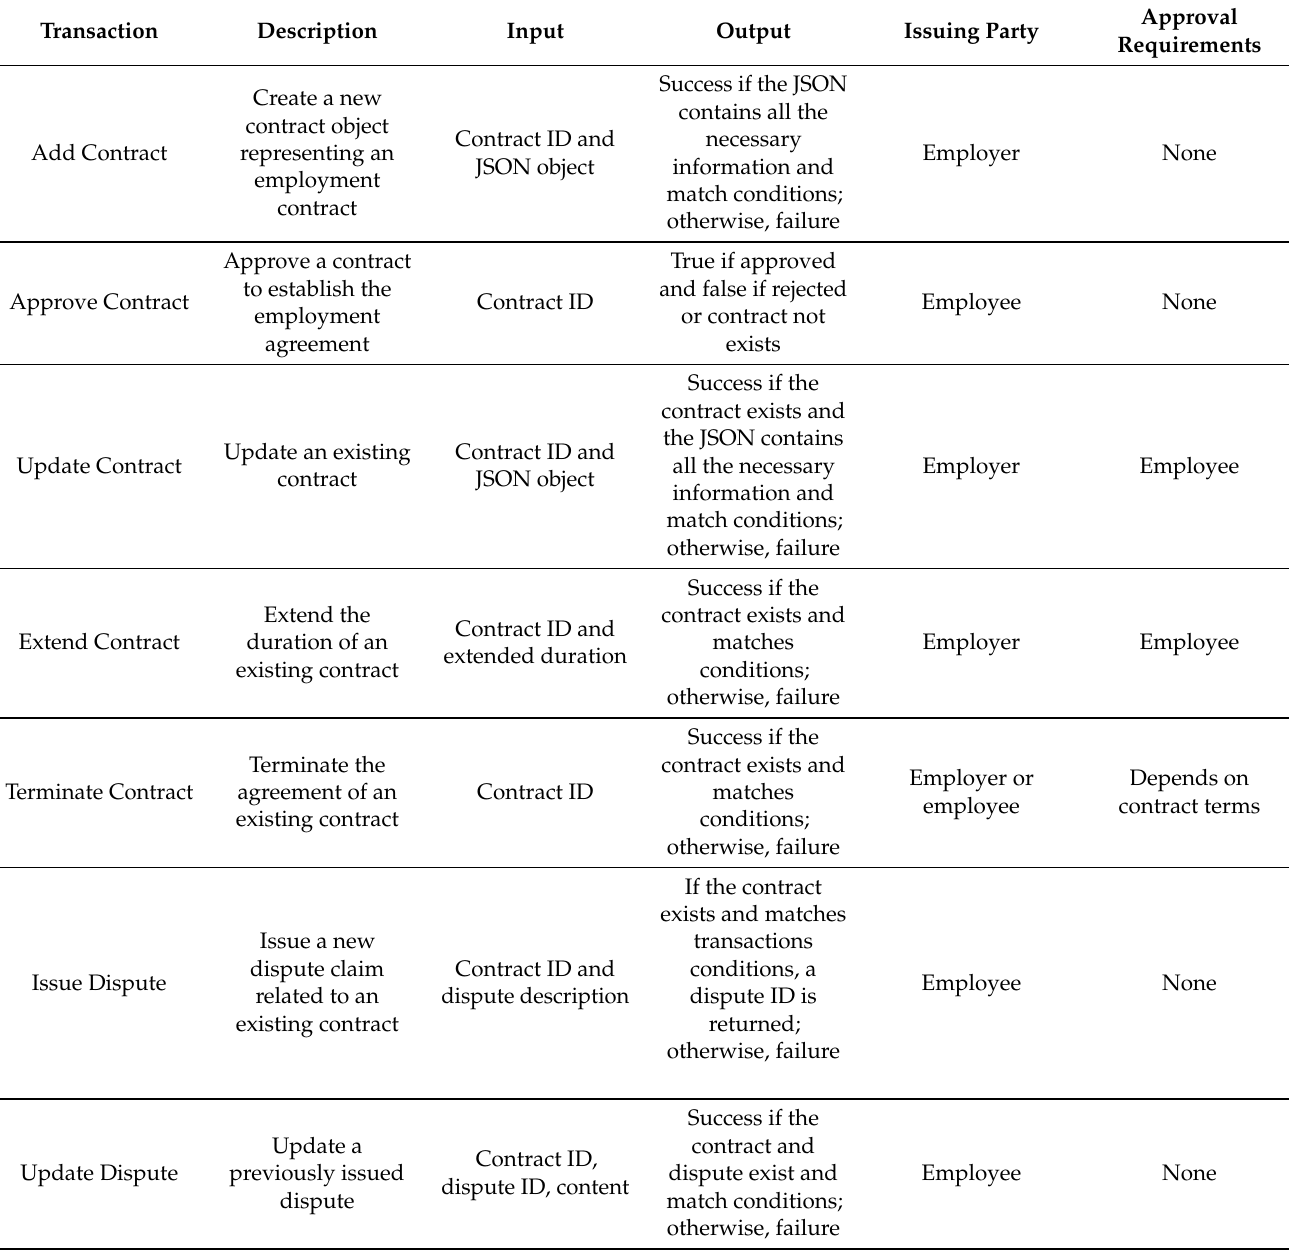
Table 2. A proposed design of smart contract transactions and their